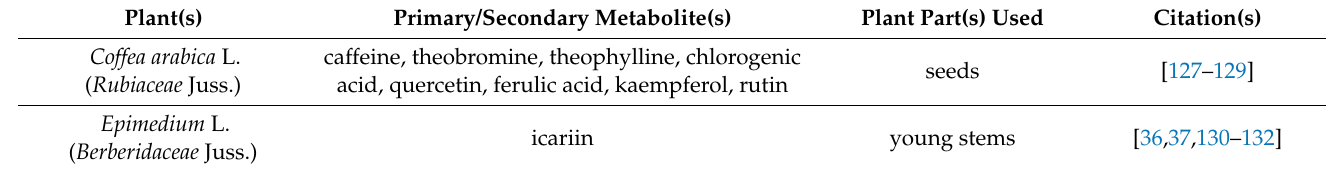
Table 3. Inhibition of phosphodiesterase.